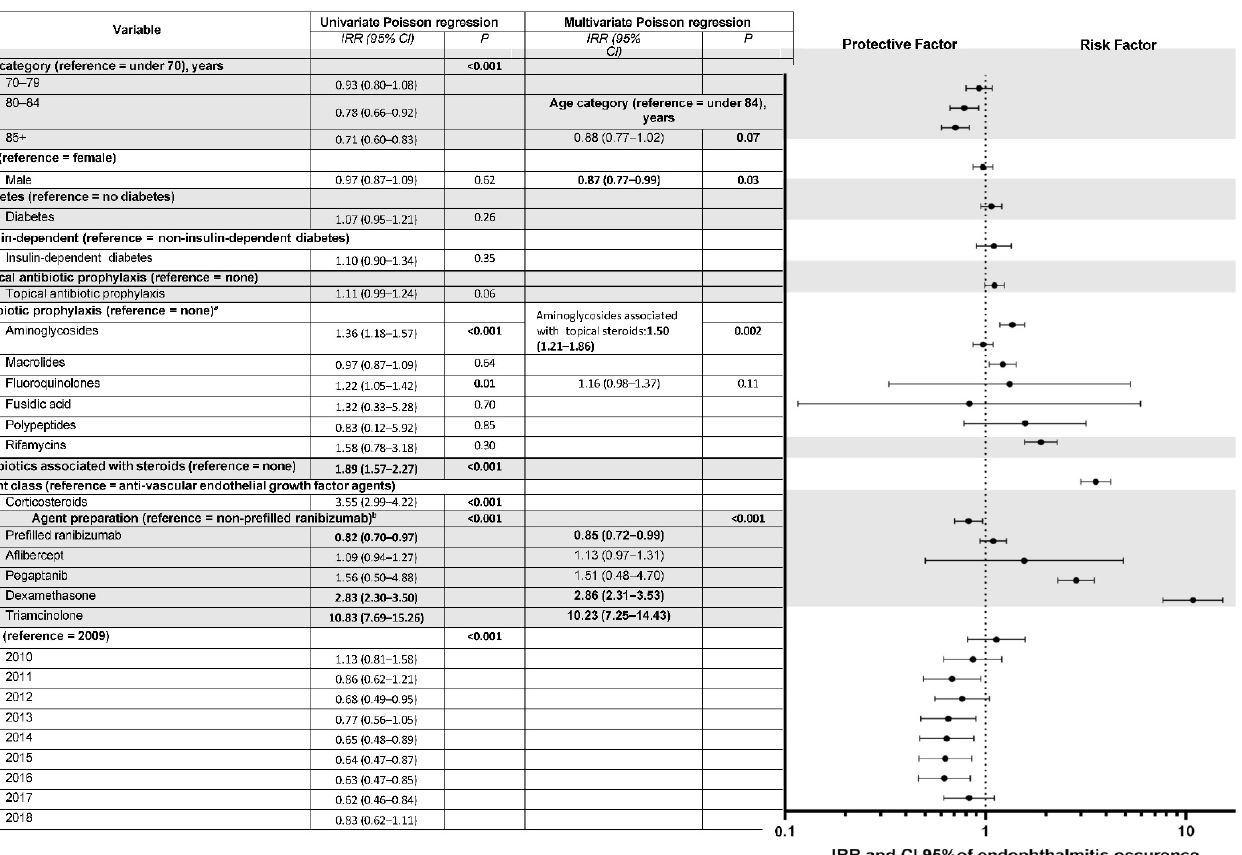
Figure 4. Univariate and multivariate analysis of factors associated with acute endophthalmitis after intravitreal injections of corticosteroids or anti ‐ VEGF (vascular endothelial growth factor) agents from 2009 to 2018. IRR = incidence rate ratio; CI = confidence interval. Missing data for agent class and specific agent, n = 259,802. Multivariate Poisson regression with variable selection based on significant association with the event and on the quasi ‐ likelihood under the independence model criterion (QIC) proposed by Pan, used to compare GEE models [16]. a Since we recorded only one prescription of phenicol antibiotics, univariate analysis is not shown for this class. b Since no endophthalmitis occurred after intravitreal bevacizumab injections, these 13,562 injections were not considered for the by ‐ agent analysis.